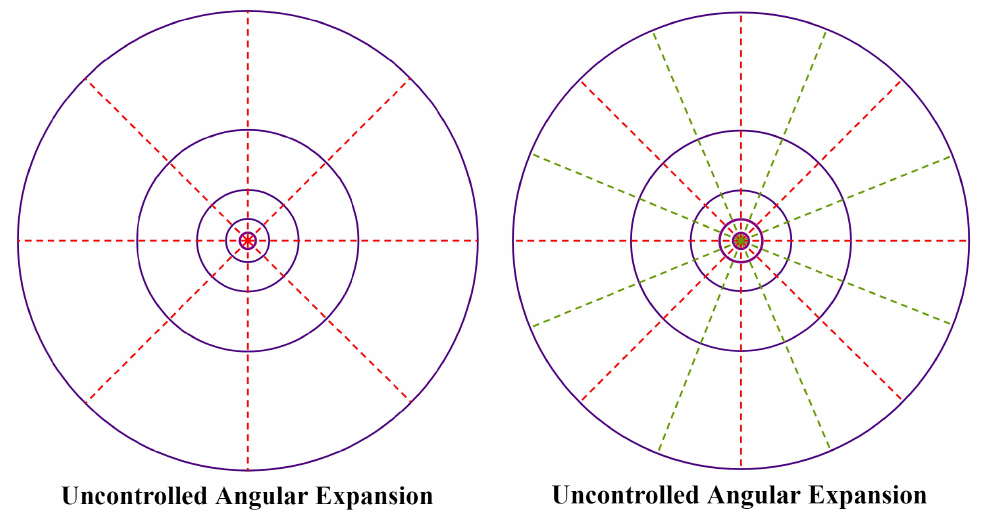
Figure 1. Basic discrete sampling grid for j = 0,2,4,6,8 with L = 8 ( left ) and L = 16 ( right )